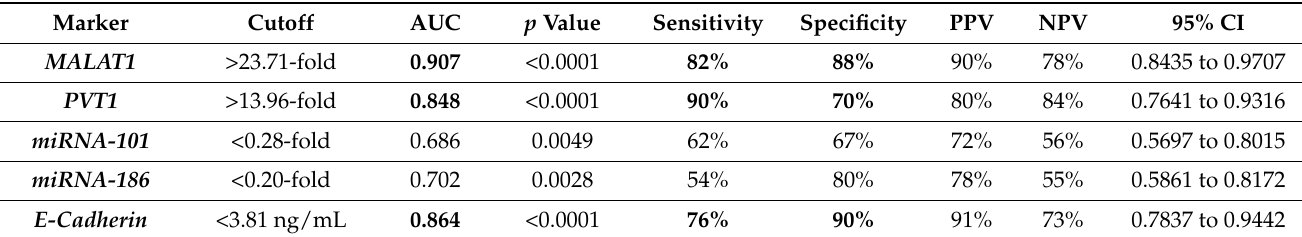
Figure 5. The prognostic performance of serum E-cadherin. Using ROC curve analysis, metastatic patients ( n = 24), non-metastatic patients ( n = 116). Table 5. Diagnostic accuracy of the studied markers between CRC and non-CRC